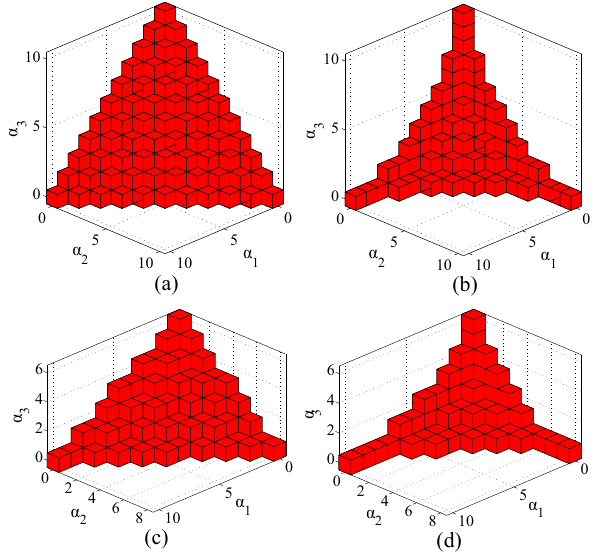
Figure 1: Index sets for different truncation schemes when d = 3 : (a) isotropic truncation with p = 10 and q = 1 ( 286 functions), (b) isotropic truncation with p = 10 and q = 0 . 7 ( 120 functions), (c) anisotropic truncation with p 1 = 10 , p 2 = 8 , p 3 = 6 and q = 1 ( 139 functions), and (d) anisotropic truncation with p 1 = 10 , p 2 = 8 , p 3 = 6 and q = 0 . 7 ( 72